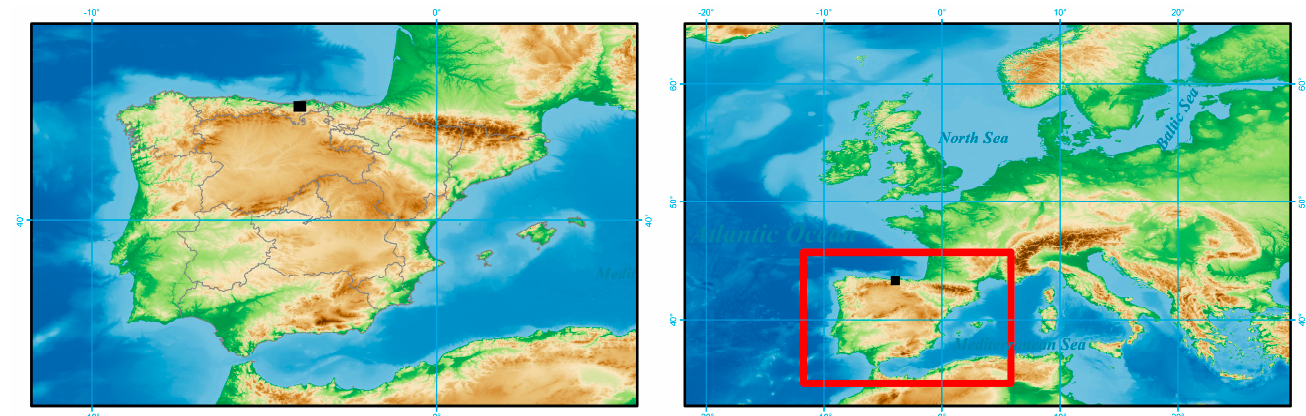
Figure 1. Location map of El Castillo Cave. The cave is located in Puente Viesgo, Cantabria, Spain.